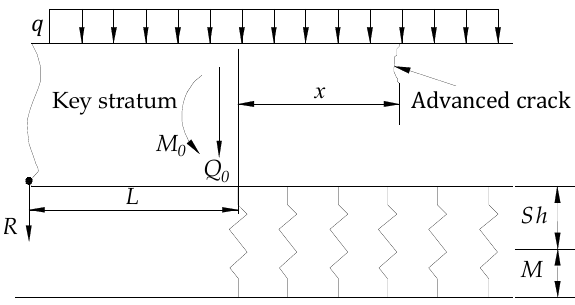
Figure 3. Mechanical model of periodic breaking of key stratum.